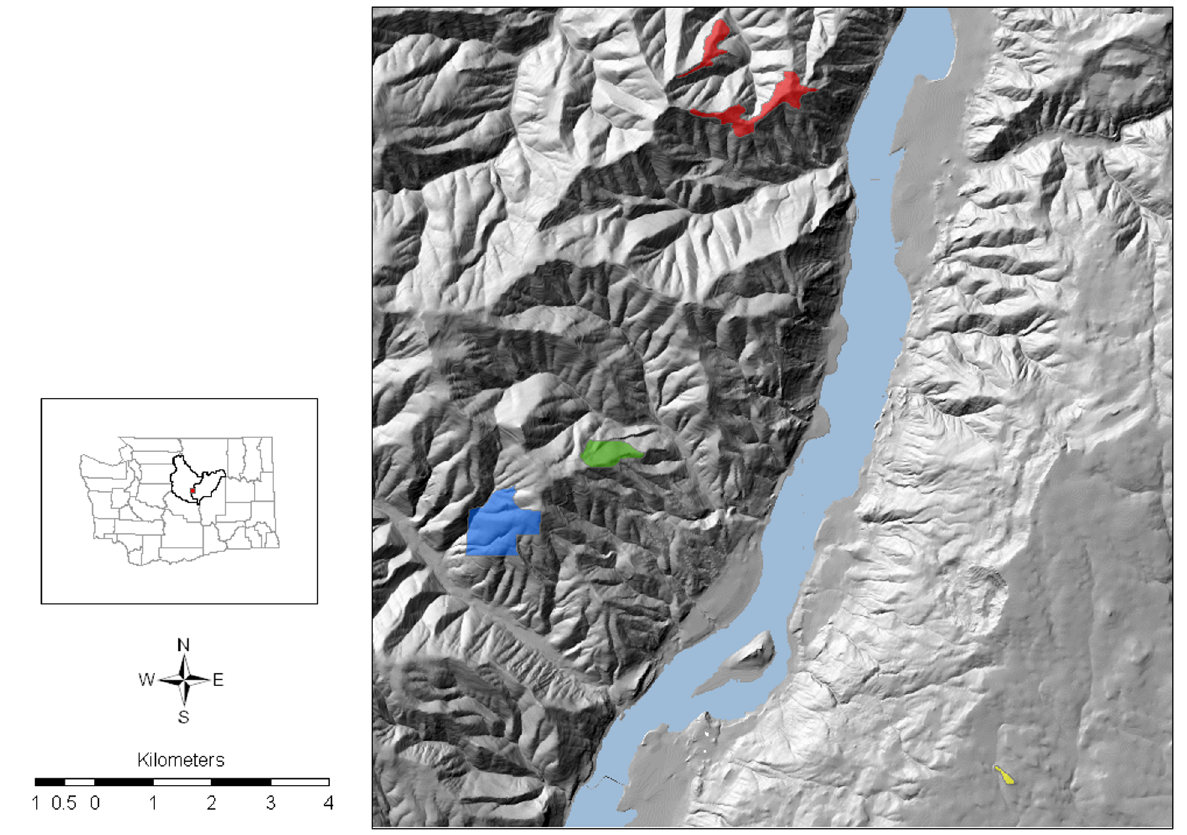
Figure 1. Location of studied populations of Trifoliumthompsonii in Washington State, USA. Inset map shows Douglas and Chelan county, where Thompson clover is endemic. Four populations were studied: KEYSTONE (red), TENAS (green), RNA (blue) and BADGER (yellow, located east of the Columbia river, and south of RNA).